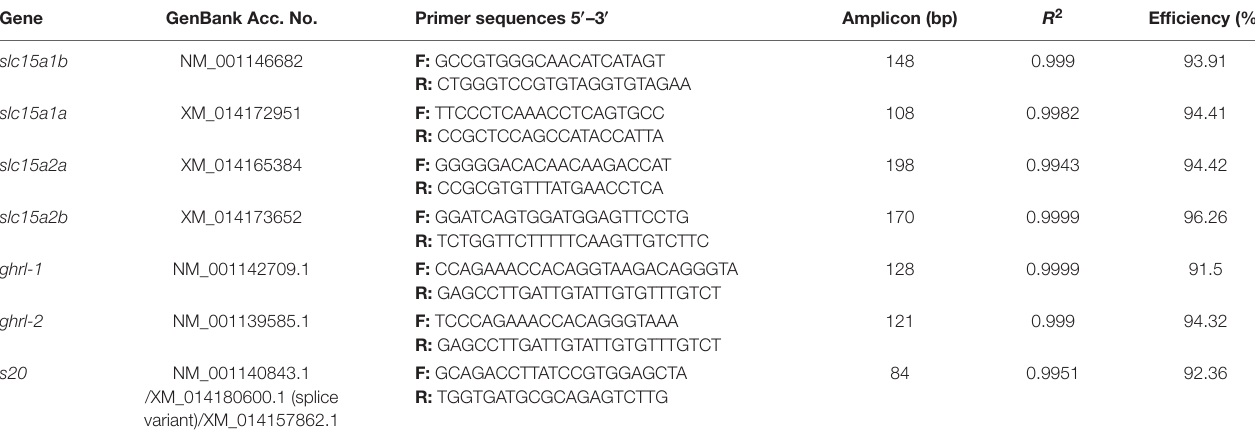
TABLE 1 | Primer sequences for reverse transcription quantitative PCR (RT-qPCR) expression analysis in Atlantic salmon. Gene GenBank Acc. No. Primer sequences 5 (cid:48) –3 (cid:48) Amplicon